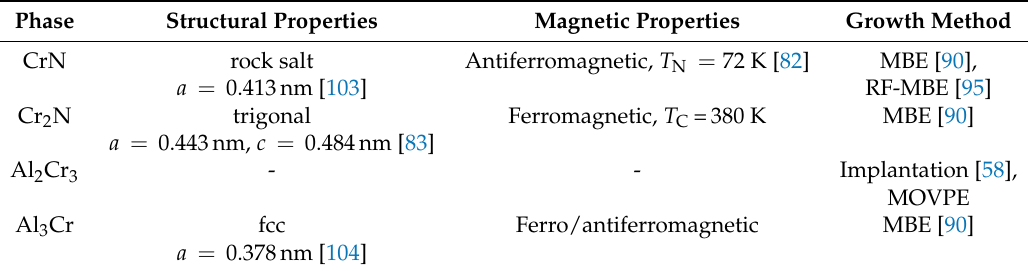
Table 3. Observed secondary- phases in Cr-doped AlN and GaN, their structural and magnetic properties, as well as the growth technique of the